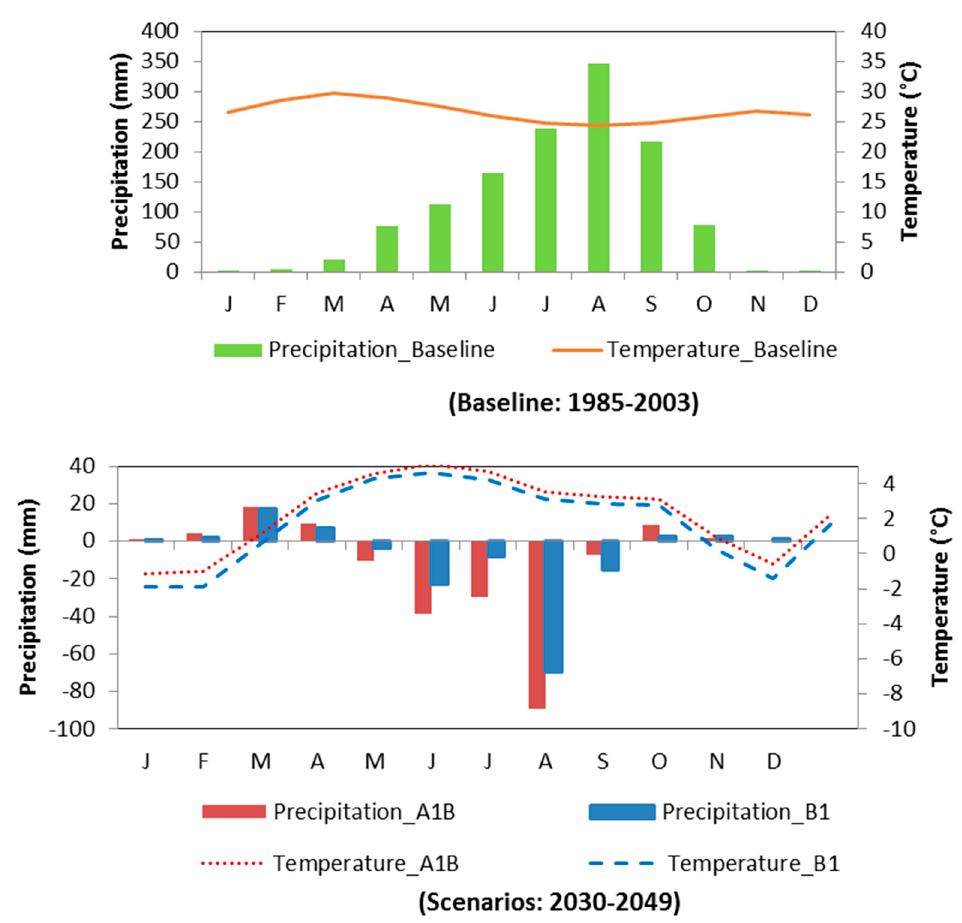
Figure 3. Monthly average precipitation and temperature during baseline period from 1985 to 2003, and changes in precipitation and temperature under climate change scenarios A1B and B1 during the period from 2030 to 2049.